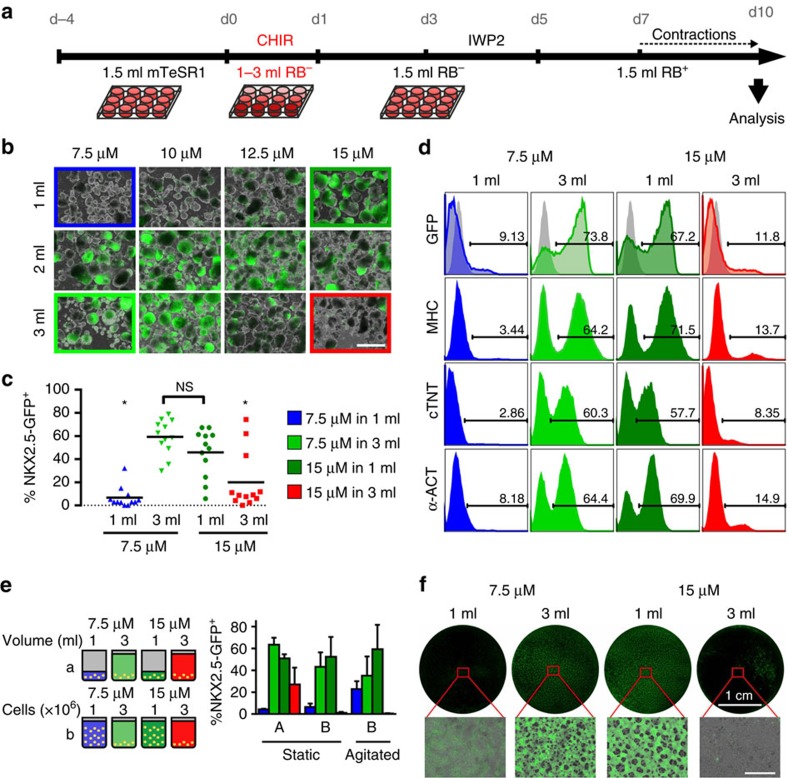
The CHIR-to-volume ratio during the first 24 h dictates differentiation outcome.(a) Schematic of expansion and subsequent differentiation. The medium volume of 1–3 ml and consequently the BCD is only modulated between day 0–1. (b) Representative images of the differentiation on day 10 using the NKX2.5-GFP cell line. The cornerstone conditions are marked by a coloured rectangle. Scale bar, 1 mm. (c) Analysis of NKX2.5-GFP+ on day 10 of the four cornerstone conditions, n=11 independent experiments. The mean is shown as black line. *P<0.01, evaluated by one-way analysis of variance with post hoc Bonferroni analysis. (d) Representative histograms for NKX2.5-GFP+ and staining against structural cardiac markers on day 10 obtained by flow cytometry. (e) Schematic of experiment (left) and corresponding NKX2.5-GFP+ on day 10 (right) in standard conditions using identical cell numbers in different volumes (A) and in identical volume with adapted cell numbers for static as well as agitated conditions (B). Bars represent mean±s.e.m. of n=3 independent experiments. (f) Representative images of NKX2.5-GFP expression on day 10 of differentiation performed in 2D monolayer cultures. Scale bar, 1 mm. See also Supplementary Fig. 1. NS, not significant.